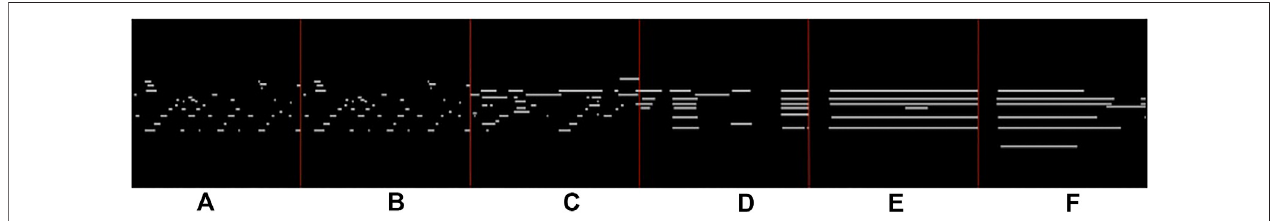
FIGURE 10 | StyleGAN Pianorolls is able to generate a variety of musical ideas (A – F) . The latent space can also be interpolated between 2 outputs to generate a musically-meaningful sequence. In this case, the generated sequence exhibits how the network morphs from sample A to sample F in 4 steps, visually divided by a red line for easier